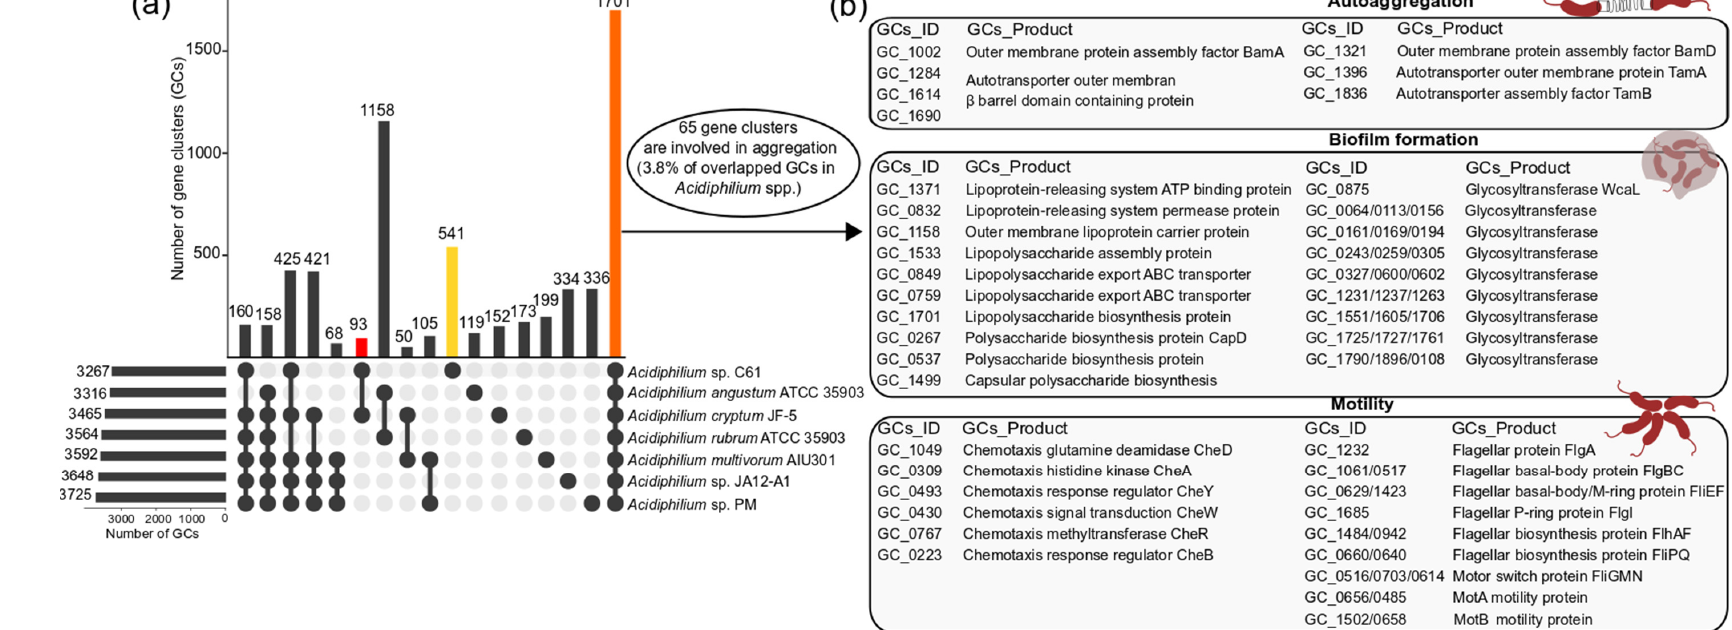
Figure 3. Genome comparison and identification of overlapping gene clusters (GCs) involved in bacterial aggregation of Acidiphilium sp. C61. (a) Intersect plot of the genome comparison of Acidiphilium sp. C61 with 6 other Acidiphilium sp. The horizontal bar chart in panel (a) corresponds to the total number of GCs found in each Acidiphilium strain. The vertical bar chart in panel (a) depicts the number of shared or unique GCs of intersected set under the corresponding species name and dark connected dots on the bottom panel indicate which Acidiphilium sp. is linked to each intersected set. The orange bar corresponds to the total number of overlapping GCs in all 7 Acidiphilium spp., the yellow bar corresponds to the total number of unique GCs found in Acidiphilium sp. C61, and the red bar corresponds to the total number of unique overlapping GCs between Acidiphilium sp. C61 and Acidiphilium cryptum JF-5, both of which were isolated from the same acidic lake (Lake77). Note, only overlapping GCs with a value greater than 50 are shown. (b) Schematic representation of a subset of overlapping GCs involved in aggregation. The GCs linked to these 3 categories (autoaggregation, biofilm formation, motility) were identified based on homologous functions to genes encoding for known aggregation mechanisms. Briefly, the 1701 shared GCs present in all Acidiphilium spp. were manually inspected based on annotated gene functions. Amino acid sequences of overlapping GCs linked to autoaggregation, biofilm formation, and motility were subset and compared to the Acidiphilium sp. C61 genome using BLAST (autoaggregation) or annotated using dfast (biofilm formation and motility). The IDs (GCs_ID) and corresponding annotated functions (GCs_Product) for the identified GCs are shown. In some cases, multiple GCs encode for the same function.